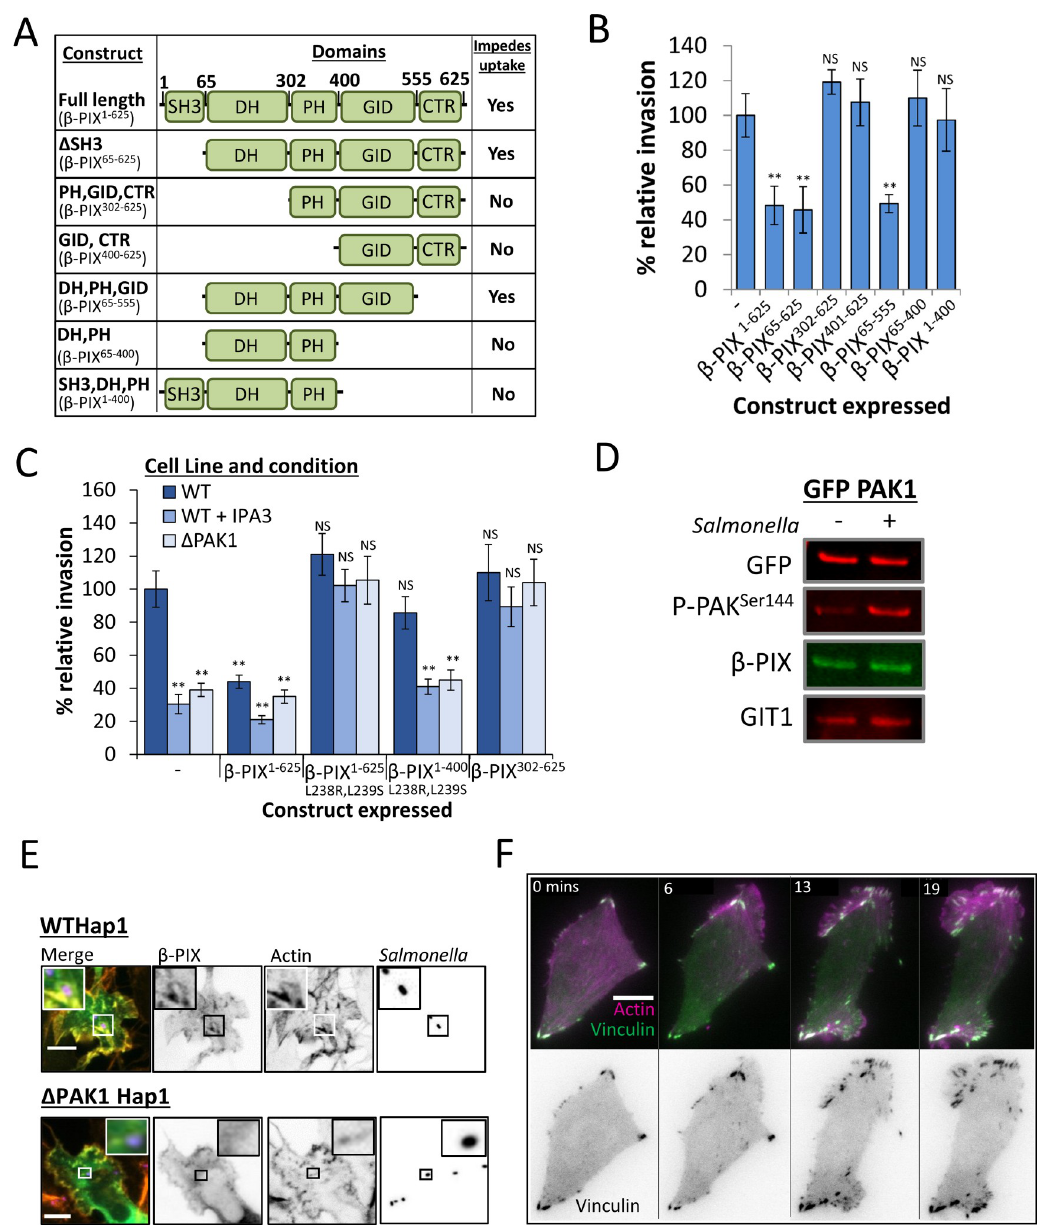
Fig 5. β -PIX GEF activity at Focal adhesions negatively regulates Salmonella invasion. (A) Schematic showing the major β - PIX domains, and the truncated variants of β -PIX used in (B) . β -PIX has 5 distinct domains: an N-terminal PAK-binding SH3 domain (SH3), a dbl-Homology GEF domain (DH), a lipid binding Pleckstrin-homology domain (PH), a GIT interaction domain (GID) and a C-terminal region (CTR). Table also summarises the effect the constructs have on invasion when expressed in WT cells, from the data in (B) . (B) Invasion of WT Salmonella into WT Hap1 cells expressing the indicated construct. Invasion values are relative to control WT cells. (C) Invasion of WT Salmonella into WT, Δ PAK1 and WT Hap1 cells pretreated with IPA3. Cells expressed the indicated construct: control (-), full length β -PIX ( β -PIX 1-625 ), full length β -PIX with a mutation in the DH domain that ablates GEF activity ( β -PIX 1-625 L238R,L239S ), the SH3, DH and PH domains of β -PIX with the same mutation ( β -PIX 1-400 L238R,L239S ) or β -PIX lacking its SH3 or DH domain ( β -PIX 302-625 ). Invasion values are relative to control WT Hap1 cells. (D) Immunoblot of proteins that interact with PAK1. Emerald-tagged PAK1 was expressed in Δ PAK1 Hap1 cells 48 hrs prior to being isolated using a GFP-Trap. Cells were uninfected or infected for 20 mins with WT Salmonella . Total extracted protein was detected using a GFP antibody, and β -PIX, GIT1 and P-PAK ser144 using corresponding antibodies. (E) Fluorescence microscopy of WT and Δ PAK1 Hap1 cells expressing Emerald-tagged β -PIX (green). Cells were infected with WT Salmonella (10 mins) that had been pre-stained with Alexa fluor-350 (blue). Actin was stained with Texas-Red-phalloidin (red). Insets magnify the indicated area. Scale bar is 10 μ m. (F) Fluorescence microscopy of cells expressing Emerald-vinculin (green) and Apple-actin